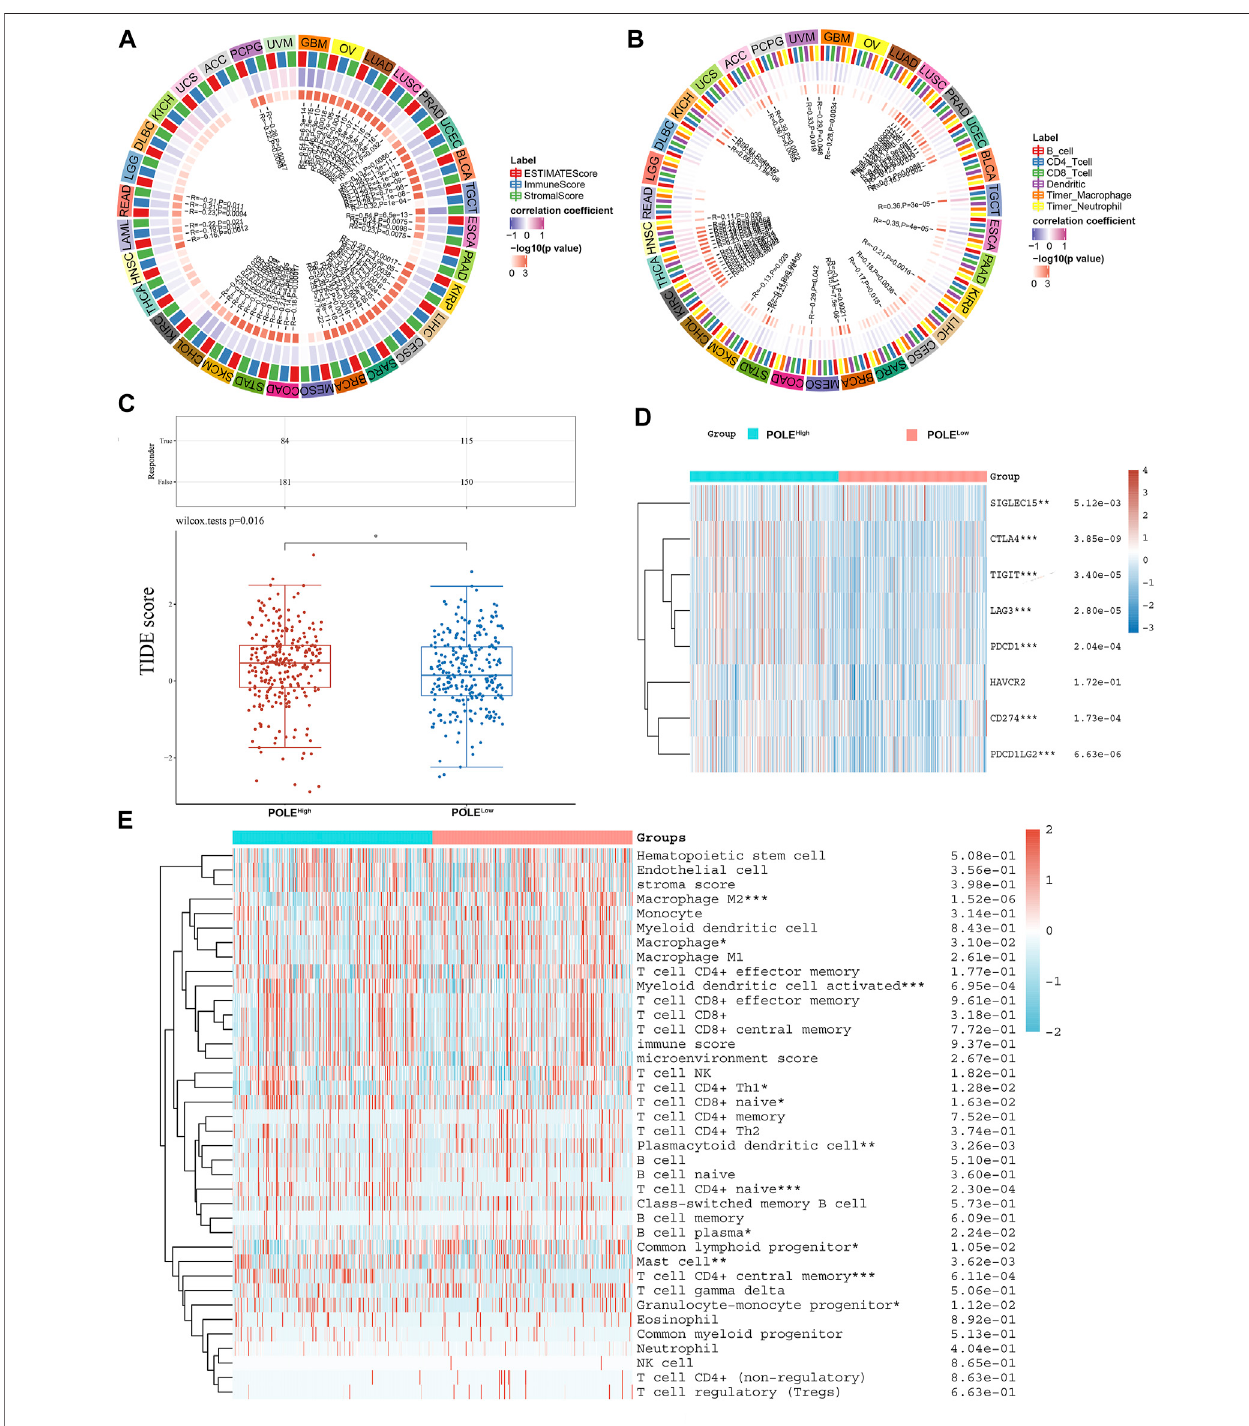
FIGURE 8 | Correlation between polymerase epsilon (POLE) expression and immune cells. (A) Signi fi cant association was found between POLE expression with estimate score, immune score, and stromal score of pan-cancer. (B) Immune cells, including B cells, T cells, dendritic cells, macrophage, and neutrophil cells, were markedly associated with the POLE expression of cancers in varying degrees, especially in clear cell renal cell carcinoma (ccRCC). (C) The TIDE algorithm is used to evaluate two different tumor immune escape mechanisms and was developed in POLE high compared with low POLE expression group in ccRCC cohort. (D) Analysesofthecomprehensivecorrelationbetweenimmunecellsandpan-cancer.ccRCCmainlyinvolvedCD56brightnaturalkillercellsandactivatedCD4Tcells.There was a signi fi cant relationship between immune cells and ccRCC, indicated by the expression of immune checkpoint molecules such as PDCD1, CTLA4, CD86, and TNFSF9. (E) Theheatmapshowsthathigh expression ofPOLE wascloselyassociatedwithM2macrophages, activated myeloiddendriticcells,plasmacytoid dendritic cells, Th1 CD4 + T cells, naive CD4 + T cells, mast cells, and granulocyte-monocyte progenitors.